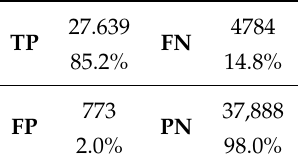
Table 6. Confusion matrix for FELSlot dataset, t =